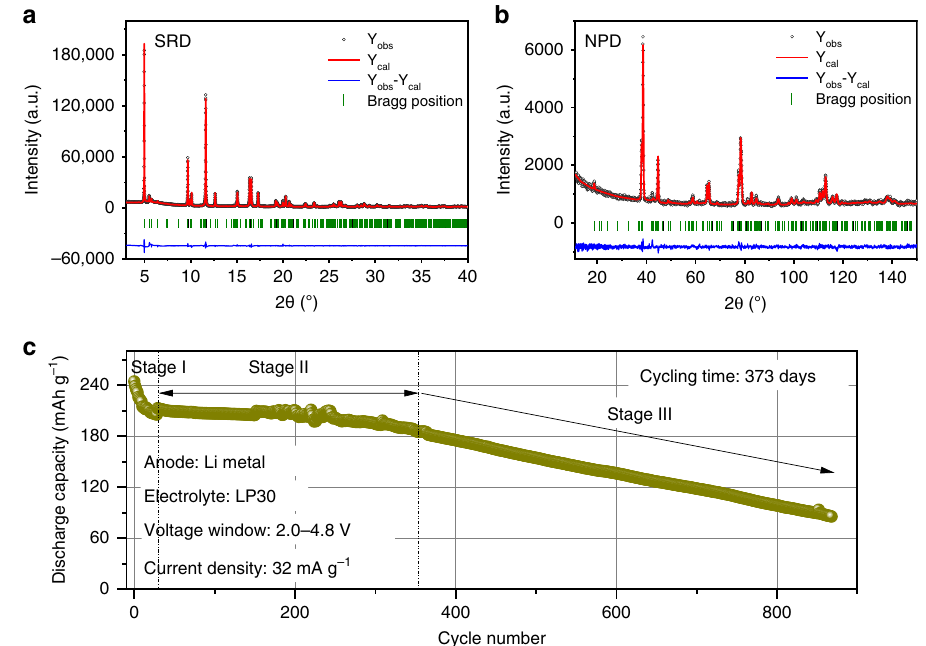
Fig. 2 Obtained monoclinic-layered Li[Li 0.2 Ni 0.2 Mn 0.6 ]O 2 cathode showing long-term degradation process. Simultaneous Rietveld re fi nement on a SRD ( λ = 0.41231 Å) and b NPD ( λ = 1.54825 Å) patterns of Li 1.2 Ni 0.2 Mn 0.6 O 2 (L1.28); c electrochemical cycling performance of L1.28 electrode vs. Li metal between 2.0 and 4.8 V at room temperature.